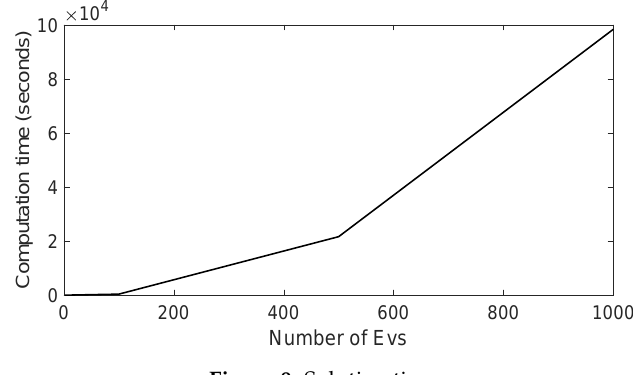
Figure 9. Solution